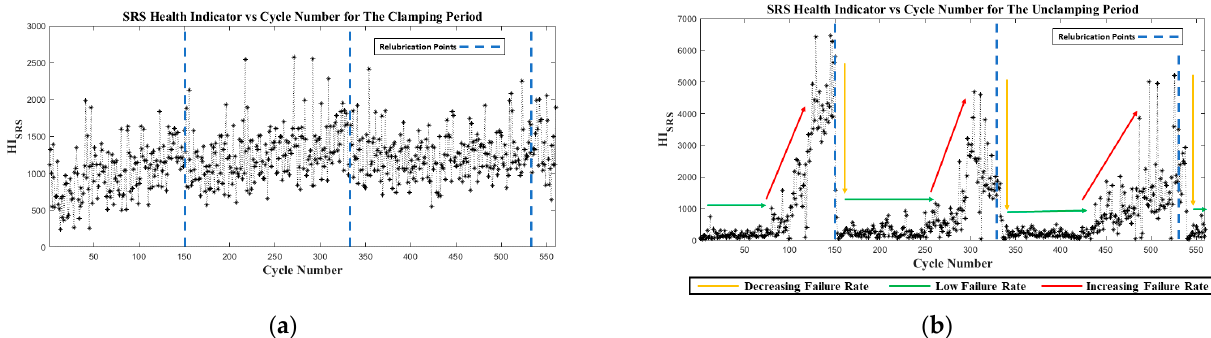
Figure 8. Structural response analysis for monitoring the lubricating condition of the toggle clamping system: ( a ) plot of SRS health indicator vs. cycle number for the clamping period; ( b ) plot of SRS health indicator vs. cycle number for the unclamping period.